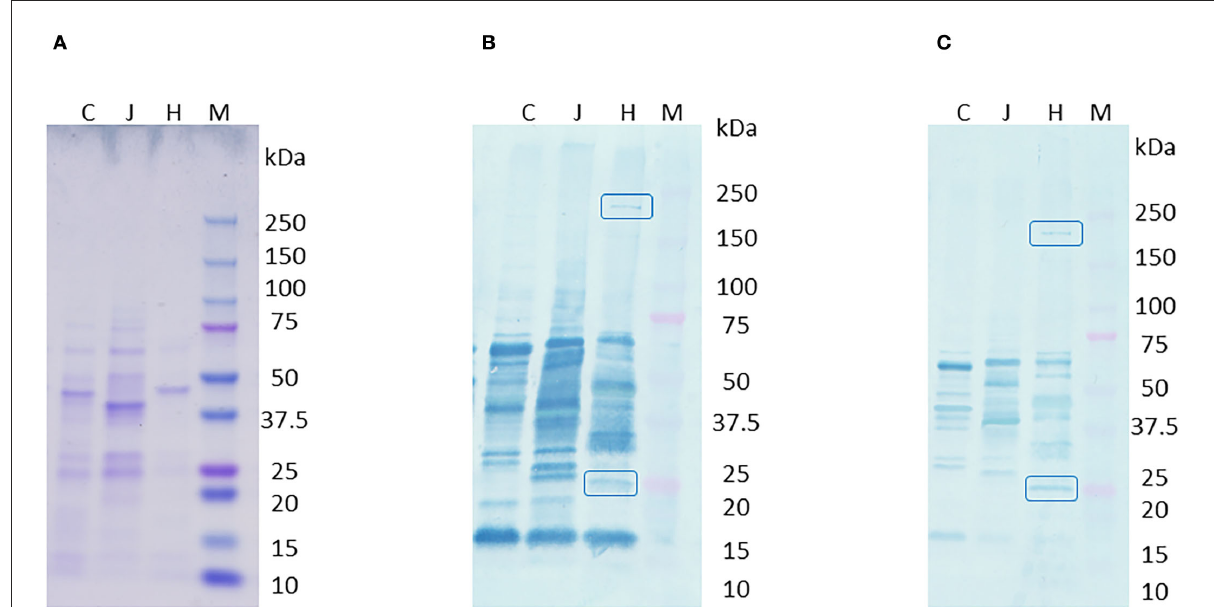
FIGURE2 Western blot of C. hepaticus , C. jejuni, and C. coli total proteins probed with pooled SLD positive sera. (A) Coomassie stained gel, (B) PVDF membrane probed with SLD positive pooled sera that showed specific bands at 220 and 25 kDa regions, and (C) PVDF membrane probed with pre-absorbed SLD positive pooled sera that still showed the specific bands at 220 and 25 kDa. Lane M–Precision plus protein ladder (Bio-Rad). Total protein profiles of C. hepaticus –H, C. jejuni –J, and C. coli –C.